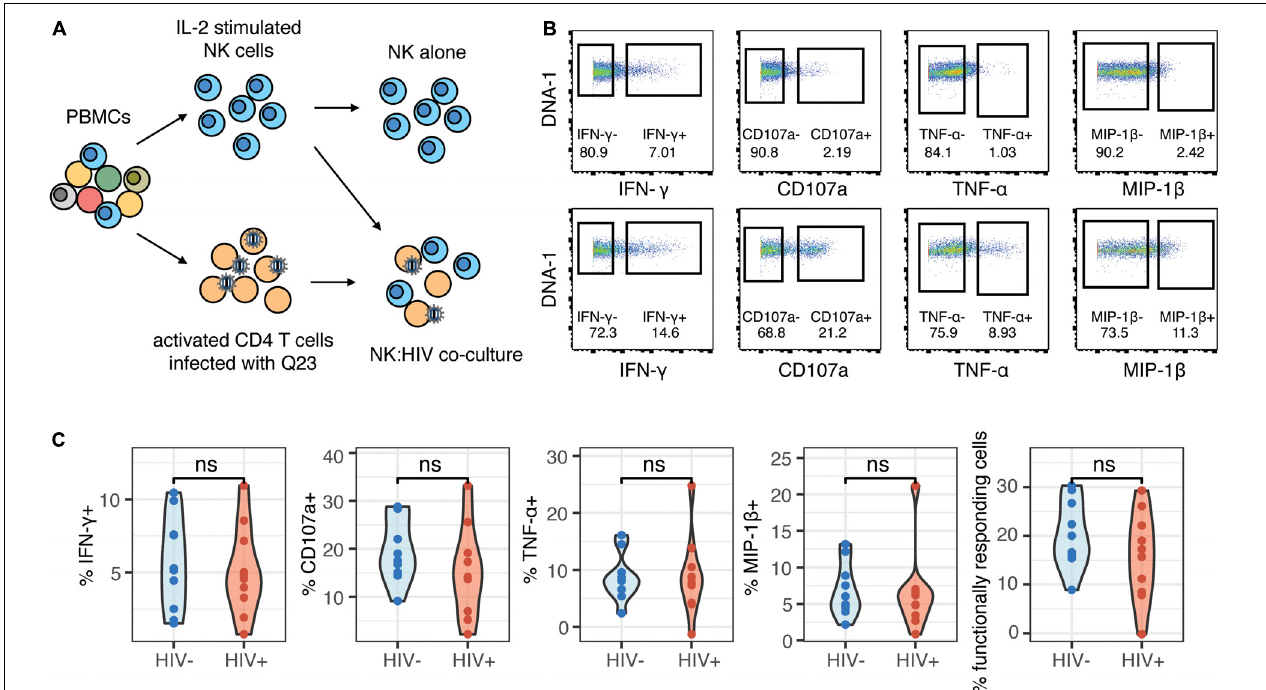
FIGURE 2 | The magnitude of the HIV-specific response does not differ between HIV- and HIV+ donors. (A) Schematic of experimental set-up for NK co-culture assays. (B) Representative flow cytometry plots of CD107a, IFN- γ , MIP-1 β , and TNF- α production (by frequency of positive cells), after 4 h co-culture without (top) or in the presence of HIV-infected autologous CD4 + T cells (bottom). (C) Summary data of CD107a, IFN- γ , MIP-1 β and TNF- α production (by frequency of positive cells), after 4 h co-culture with HIV-infected autologous CD4 + T cells, in NK cells from HIV– ( n = 10) and HIV+ ( n = 10) donors. ns, not significant, by t